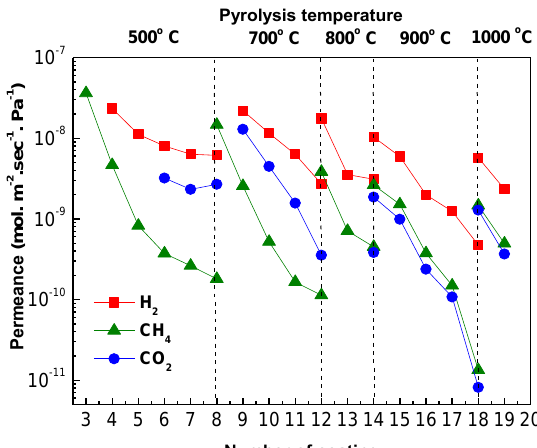
Figure 11. Permeance of H 2 , CH 4 and CO 2 as a function of number of coatings after pyrolysis at 500 °C, 700 °C, 800 °C, 900 °C or 1000 °C for sample C2-Fe.